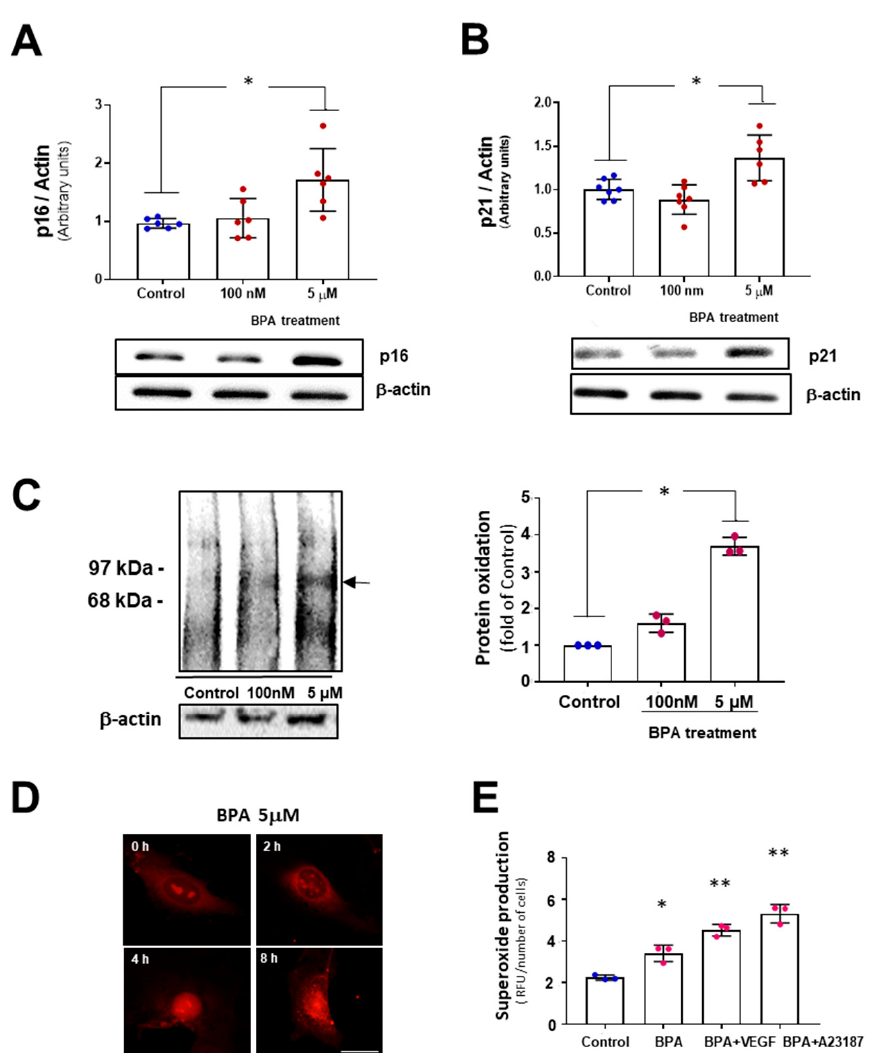
Figure 2. BPA induces senescent protein markers p21 and p16 and increases oxidative stress. Western blotting analysis of MAEC treated with 100 nM and 5 μ M BPA for five days using antibodies against ( A ) p21 and ( B ) p16. β -actin was used as a loading control. (n = 6). Results are given as mean ± SD, p was determined by a Kruskal–Wallis test for the comparison between control and BPA-treated cells.* p < 0.05 ); ( C ) The levels of reactive oxygen species induced in MAEC by BPA were analyzed by oxyblot assay in 100 nM and 5 µ M BPA-treated MAEC for 24 h to detect carbonyl groups in proteins as a marker of protein oxidation. The densities of the proteins between 97 and 68 KDa were normalized using the expression of β -actin. (n = 3 with duplicate for each condition).* p < 0.001 using Kruskal–Wallis test for the comparison between control and BPA-treated cells; ( D ) Immunofluorescence (IF) of superoxide production in MAEC in response to 5 µ M BPA for 0–8 h, using the fluorescence probe dihydroetidium (DHE). After 4 h, fluorescence can be observed at the cell nucleus. Scale bar: 10 µ m; ( E ) Quantification of superoxide in MAEC upon 5 µ M BPA treatment for 24 h, BPA+VEGF and BPA+ A23187 and vehicle (control). (n = 3, per duplicate). Results are given as mean ± SD, p was determined by a Kruskal–Wallis test, * p < 0.001 vs. Control and ** p < 0.001 vs. BPA.